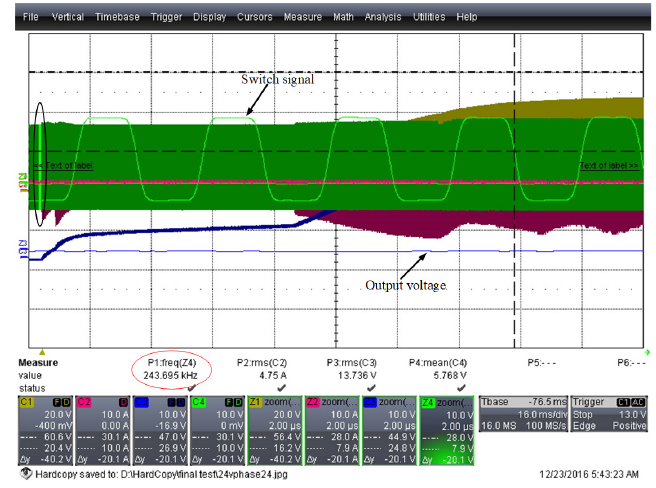
Figure 22. Original waveform of forward transfer.